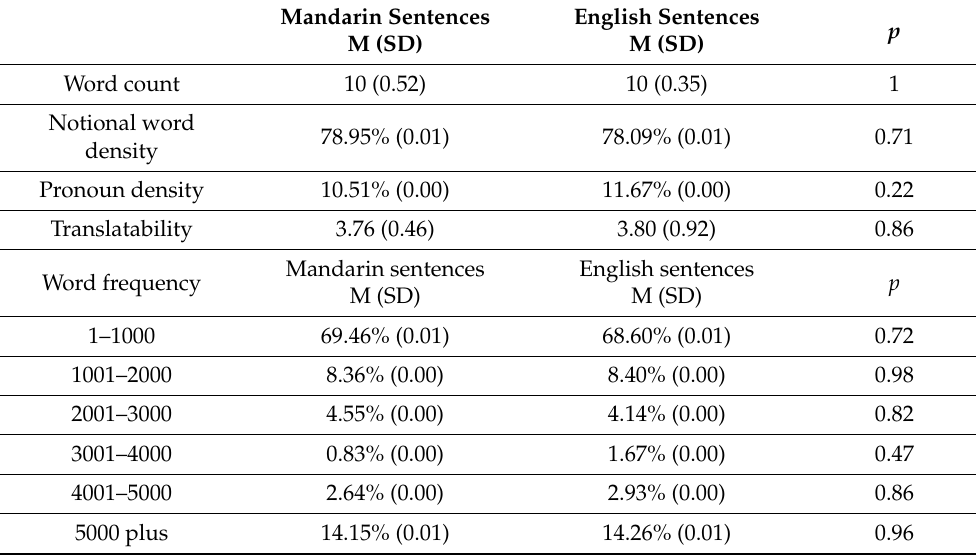
Table 2. Comparability of Mandarin and English